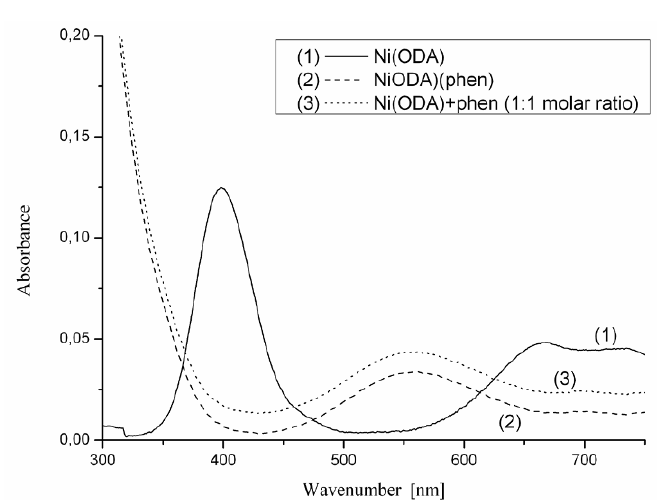
Figure 4. Electronic spectra of the substrate Ni-ODA (1), the ternary complex Ni-ODA-phen (2) and the product of the substitution reaction Ni-ODA + phen (3) in an aqua solution.